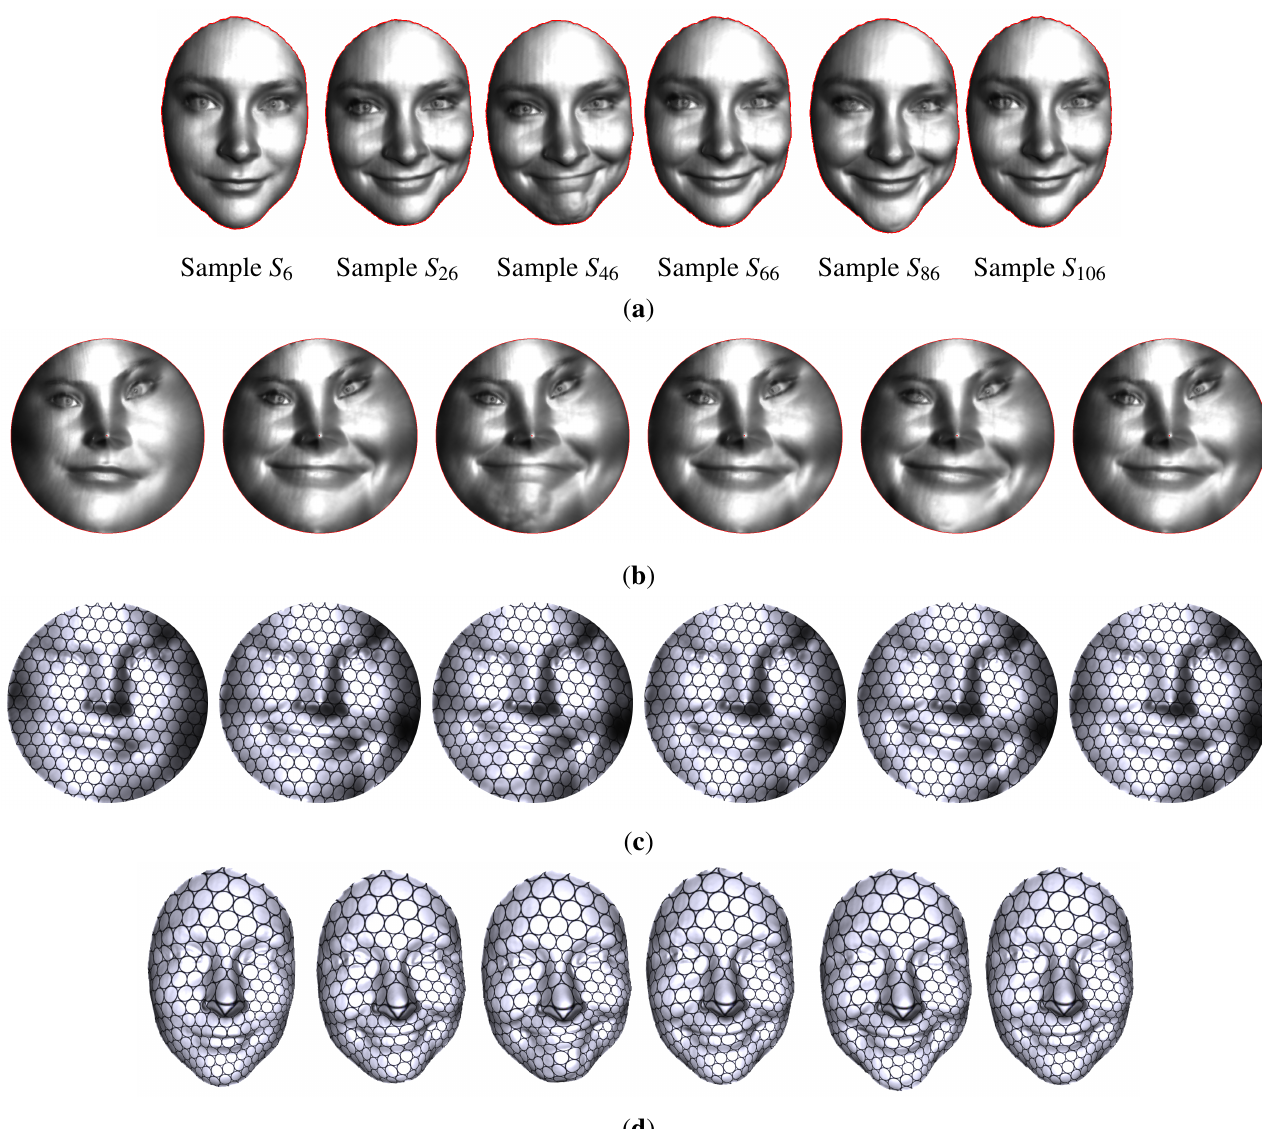
Figure 7. Diffeomorphisms interpolation and its application for inter-frame registration. ( a ) Surface ( b ) corresponding interpolated diffeomorphisms on the 2D domain h t texture mappings on interpolation frames h t interpolation frames f t